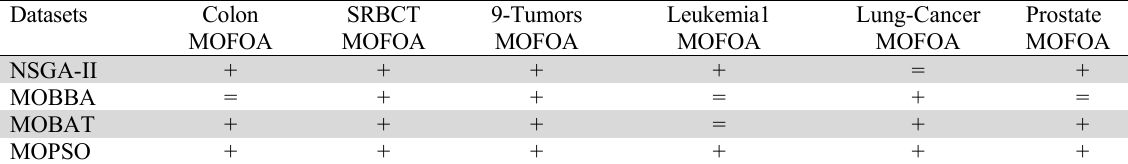
Wilcoxon rank-sum test of hypervolume ratios in the train data Datasets